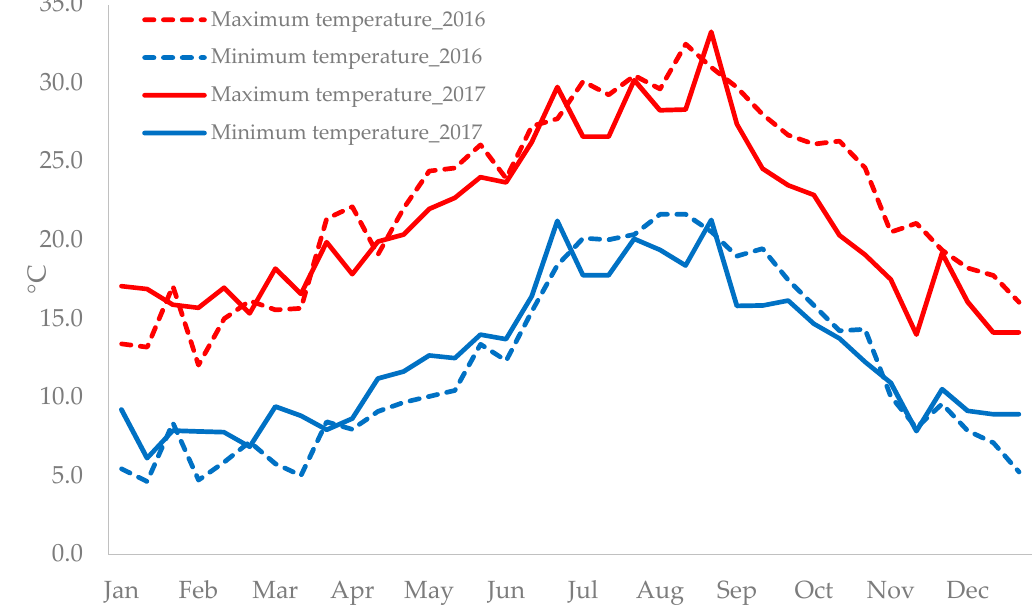
Figure 2. Minimum and maximum air temperature at Sciacca, Agrigento province (longitude 13°07’ E, latitude 37°30’ N, altitude 31 m) during the growing cycles (2016 and 2017).